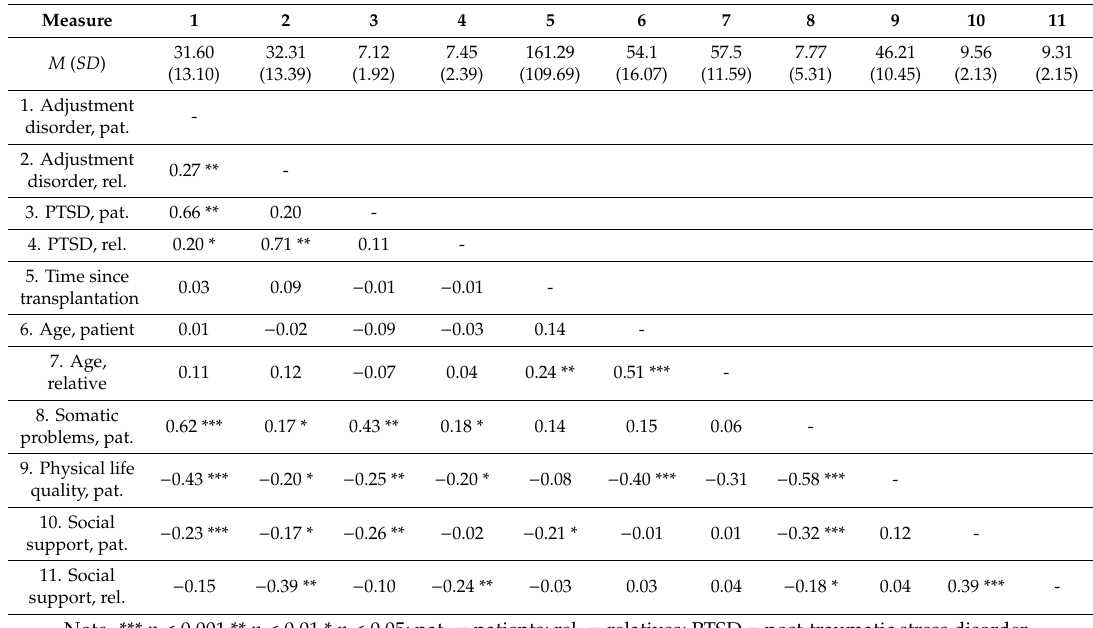
Table 2. Intercorrelations between main study